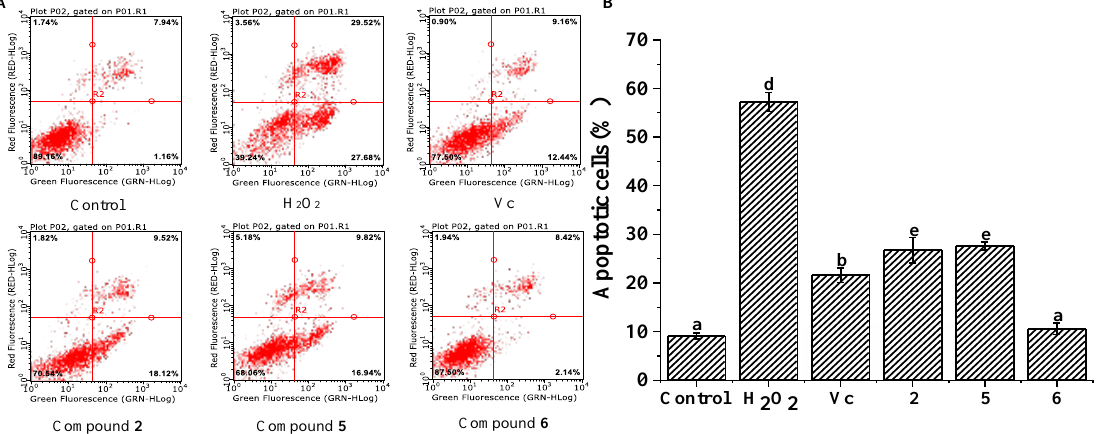
Figure 4. Cytoprotective effect of the compounds 2 , 5 , and 6 on apoptosis in H 2 O 2 -induced HepG-2 cells. ( A ) Flow cytometry analysis; ( B ) the apoptotic cell percentage of different groups. All the values are presented as mean ± SD ( n = 3). Means (bar value) with different letters are significantly different ( p < 0.05).